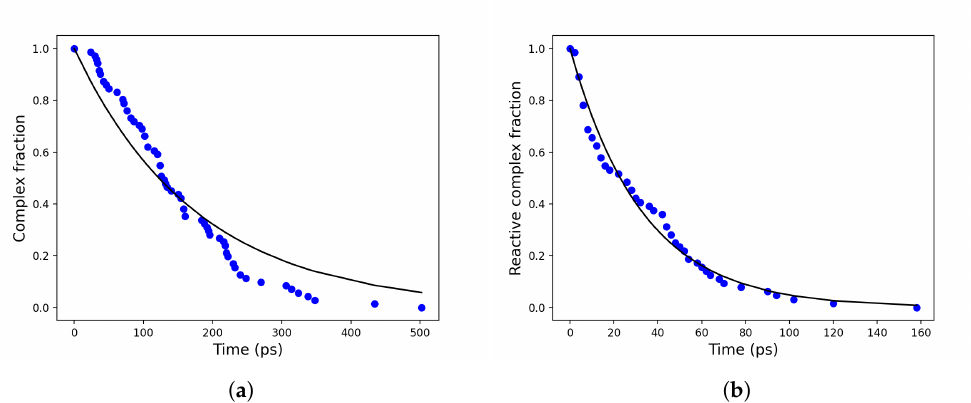
Figure 7. Time decay of the (total) complex ( a ) and the reactive complex ( b ) in blue dots and their corresponding exponential fits in solid black